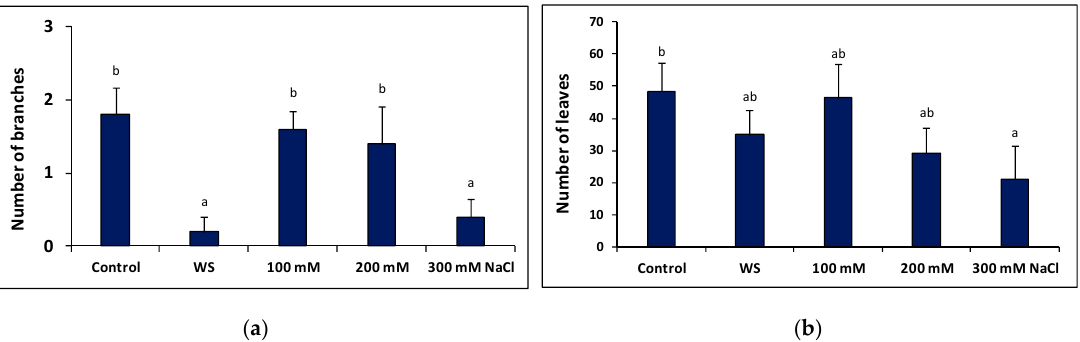
Figure 4. Number of new branches ( a ) and new leaves ( b ) formed during the 23 days of water stress (WS, complete withholding of irrigation) and salt stress (at the indicated NaCl concentrations) treatments, in Thalictrum maritimum plants grown under controlled conditions in the greenhouse. Values are calculated as the differences between the number of branches, or leaves, counted at the end and at the beginning of the corresponding treatments. Values shown are means ± SE ( n = 5). Same lowercase letters over the bars indicate homogeneous groups between treatments according to the Tukey test ( p ≤ 0.05).